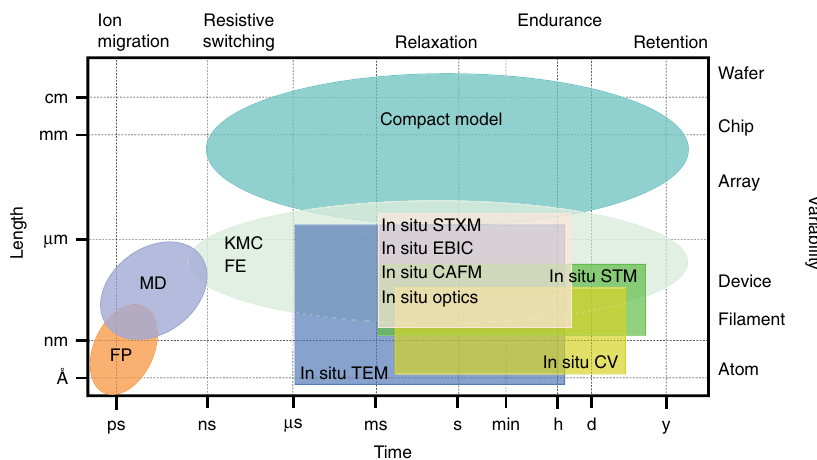
Fig. 2 Spatiotemporal resolution of various in situ techniques and device modeling methods.In situ techniques in the rectangular regions: TEM, transmission electron microscopy; CAFM, conductive atomic force microscopy; Optics, optical microscopy; EBIC, electron beam-induced current imaging; STXM, scanning transmission X-ray microscopy; STM, scanning tunneling microscopy; and CV, cyclic voltammetry. Device modeling methods in the elliptical regions: FP, fi rst principles; MD, molecular dynamics; KMC, kinetic Monte Carlo; FE, fi nite element; and compact modeling. The physical properties and electrical behaviors of memristors are marked according to their corresponding time scale, including ion migration, resistive switching, relaxation, and cycling endurance. The physical presence of memristors on a different level was marked according to the length scale, including fi lament, device, array, chip, and wafer. The parameter variability of the device performance could be introduced on each level of physical presence. Scale bars provide a visual indication of the spatiotemporal units, not proportional with the actual